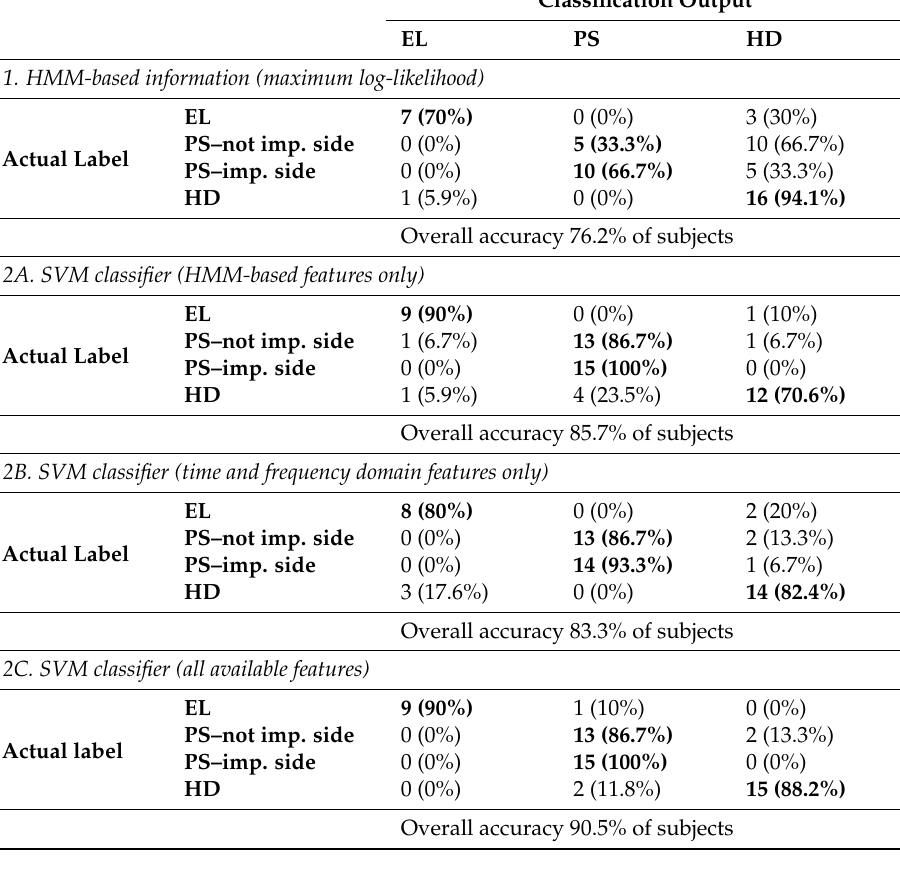
Table 4. Confusion matrices obtained after majority voting (MV). Results are reported for two different strategies: (1) solving the classification problem using HMM based information only; (2) solving the problem using a SVM classifier. In the latter case, the contributions of HMM-based features only (2A), of time and frequency domain features only (2B) and of the full features set (2C) are evaluated separately. Each entry in the matrix corresponds to a subject. Post stroke (PS) subjects were reported twice, separating the two sides contributions. Correct classifications are in bold.